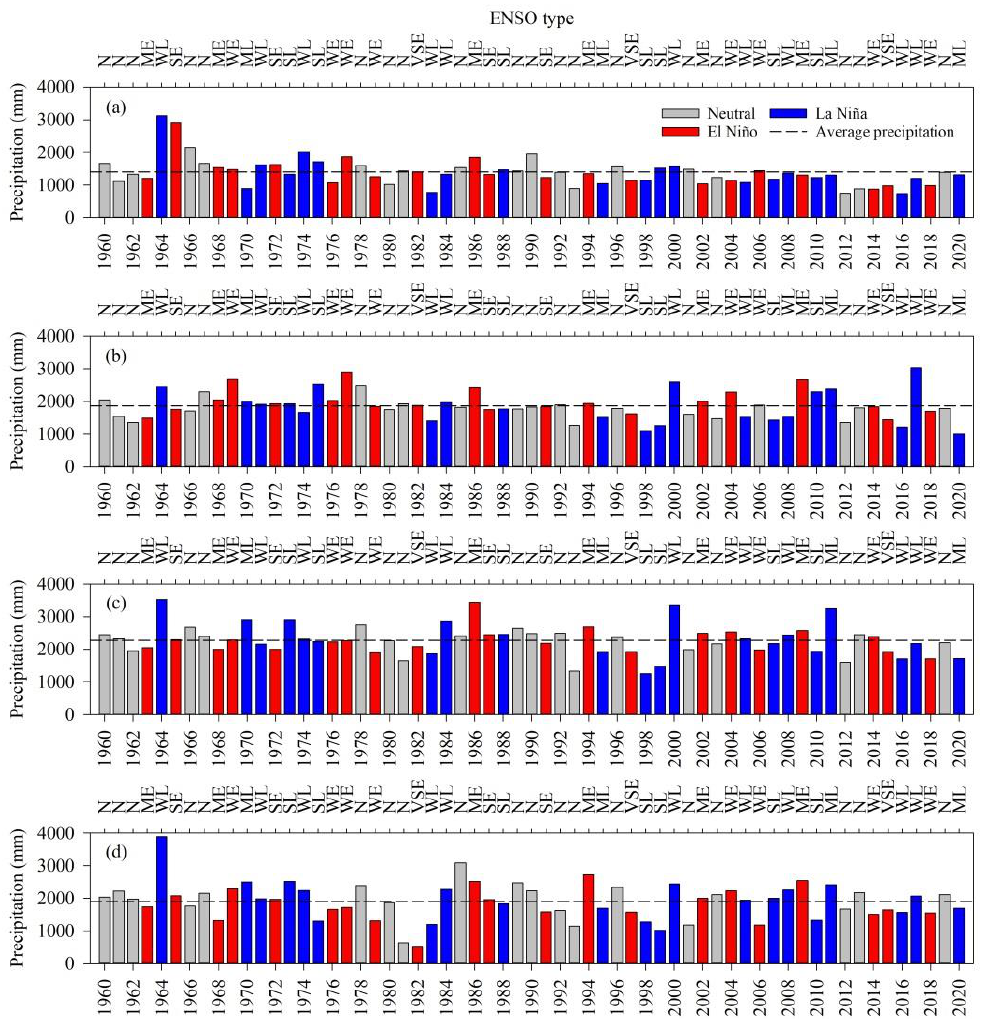
Figure 2. Annual rainfall distribution (mm/year) in ENEB capitals — Aracaju ( a ), Maceió ( b ), Recife ( c ), and João Pessoa ( d ). El Niño, La Niña, Neutral, and their intensities based on the Oceanic Niño Index (ONI): N: Neutral, WE: weak El Niño; ME: moderate El Niño; SE: strong El Niño; VSE: very strong El Niño; WL: weak La Niña; ML: moderate La Niña; and SL: strong La Niña. The colors in the bars are Neutral in grey, La Niña in blue, and El Niño in red, and the dashed line represents average rainfall for the period 1960 – 2020.